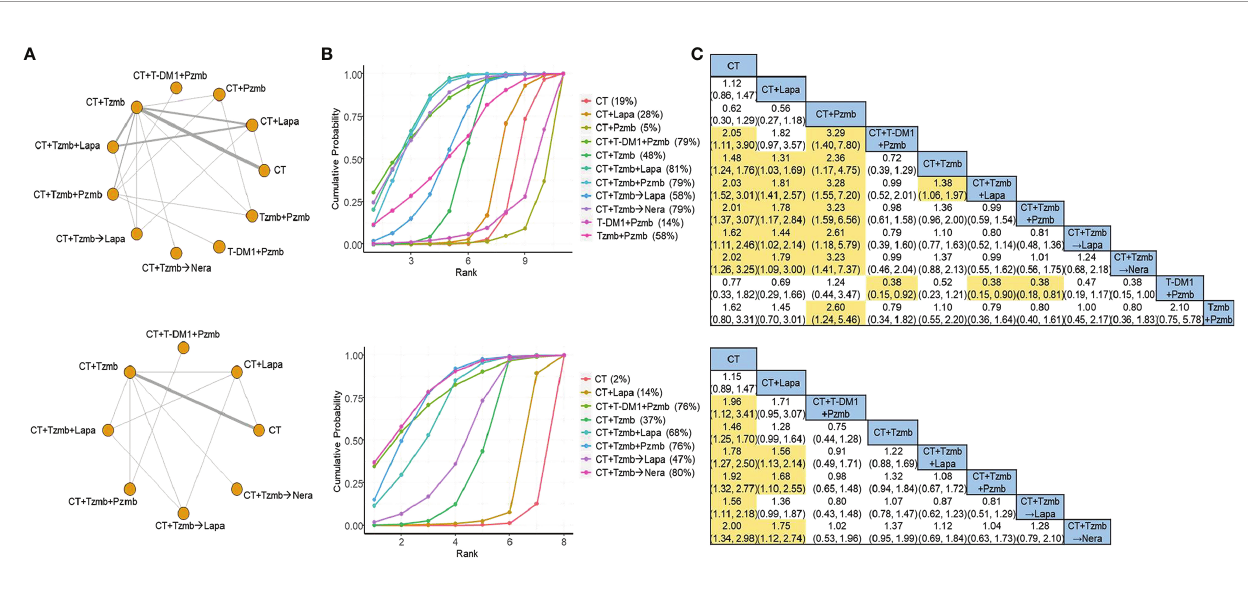
FIGURE 2 | Network meta-analysis for disease-free survival. (A) Network plots for disease-free survival in the overall analysis (top panel) and in the parallel analysis (bottom panel). (B) Ranking probabilities of surface under the cumulative ranking curve for disease-free survival in the overall analysis (top panel) and in the parallel analysis (bottom panel). (C) Cross-comparison odds ratios and their corresponding 95% con fi dence intervals for disease-free survival in the overall analysis (top panel) and in the parallel analysis (bottom panel). CT, chemotherapy; Lapa, lapatinib; Nera, neratinib; Pzmb, pertuzumab; T-DM1, trastuzumab emtansine; Tzmb,